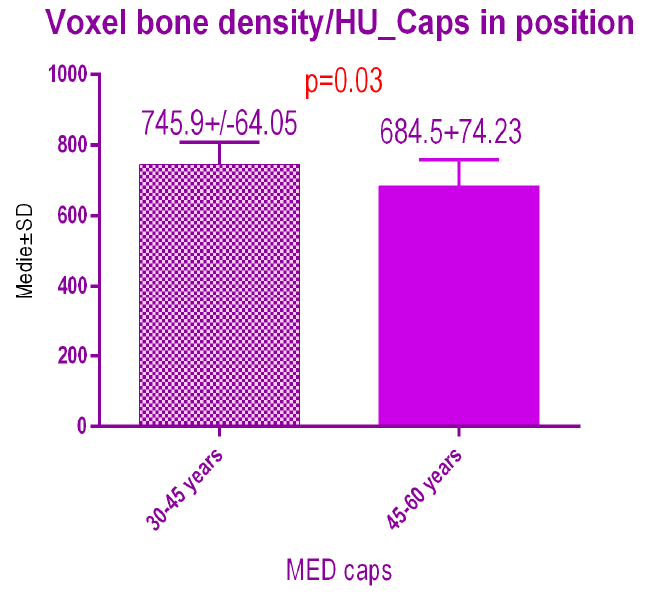
Figure 17. Bone radiodensity comparison by age after pulse electromagnetic healing caps.